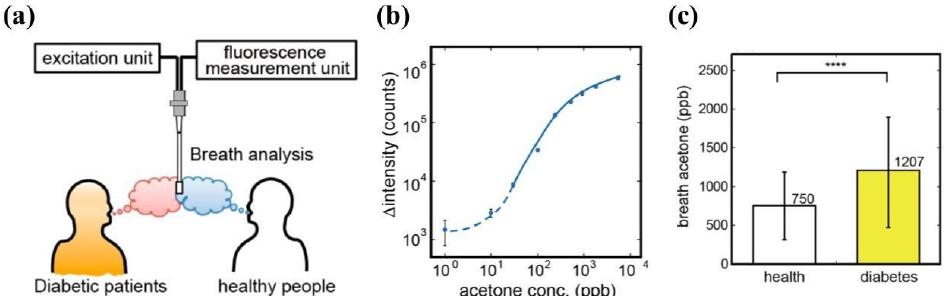
Figure 4. ( a ) Schematic representation. ( b ) Acetone biosniffers’ sensitivity. ( c ) Healthy groups’ and diabetic patients’ exhaled breath acetone (**** = p < 0.001) Reprinted with permission from [89] Copyright 2017 American Chemical Society.